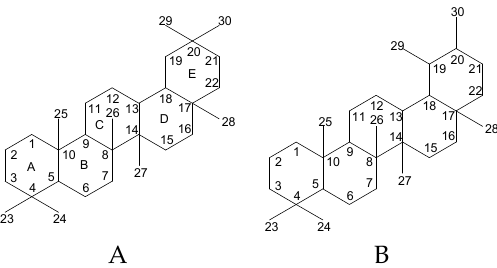
Figure 1. Representative skeletons of oleanane ( A ) and ursane ( B ) pentacyclic